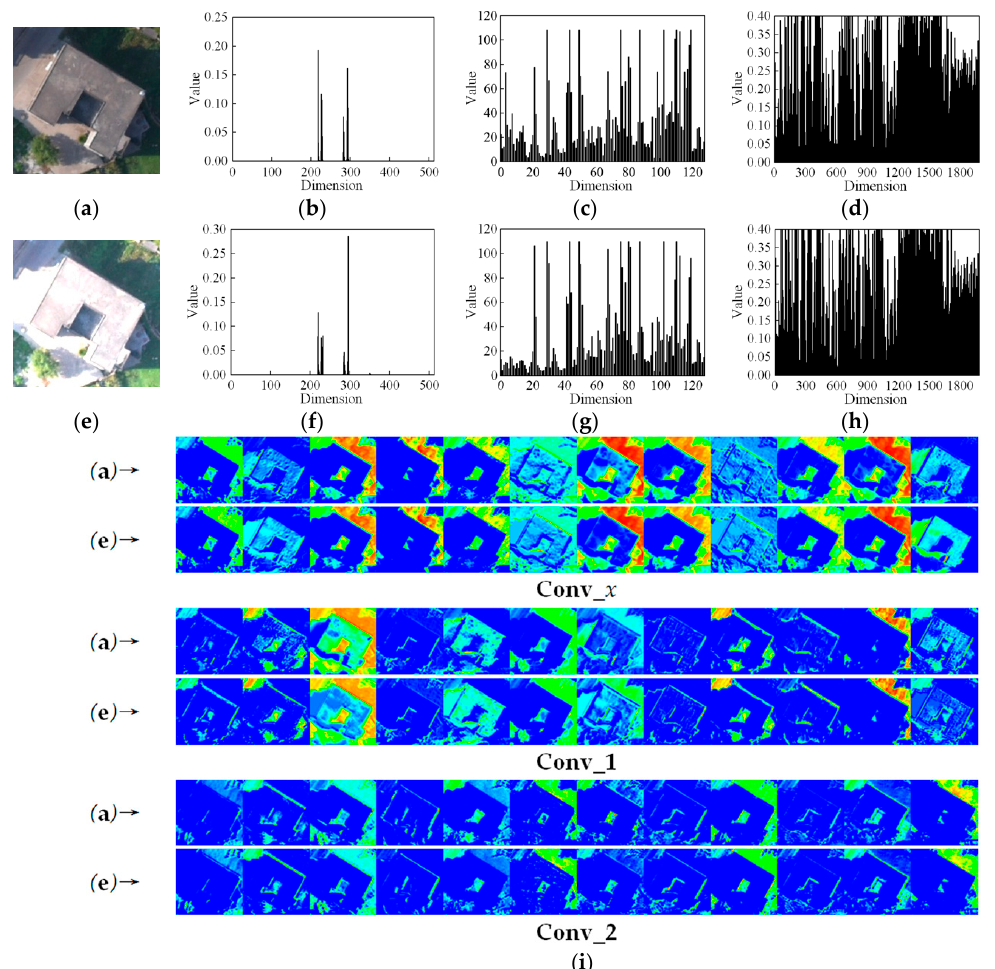
Figure 18. Comparison of features of the color histogram, SIFT, Hog, and MSCNs. ( a ) is an example of a building, and ( e ) denotes the gray variations (e.g., brightness + 50% and contrast + 50%) corresponding to ( a ). ( b ) and ( f ) are the feature vectors of the color histogram of ( a ) and ( e ), respectively. ( c ) and ( g ) are the feature vectors of SIFT of ( a ) and ( e ), respectively. ( d ) and ( h ) are the feature vectors of Hog of ( a ) and ( e ), respectively. ( i ) is the visualization of deep features extracted by MSCNs in the three convolutional layers, i.e., Conv_ x , Conv_1, and Conv_2. Only 12 feature maps are provided in each convolutional layer, and ( a ) → and ( e ) → denote the corresponding rows to the images ( a ) and ( e ) that are the feature maps of Conv_ x , Conv_1, and Conv_2.